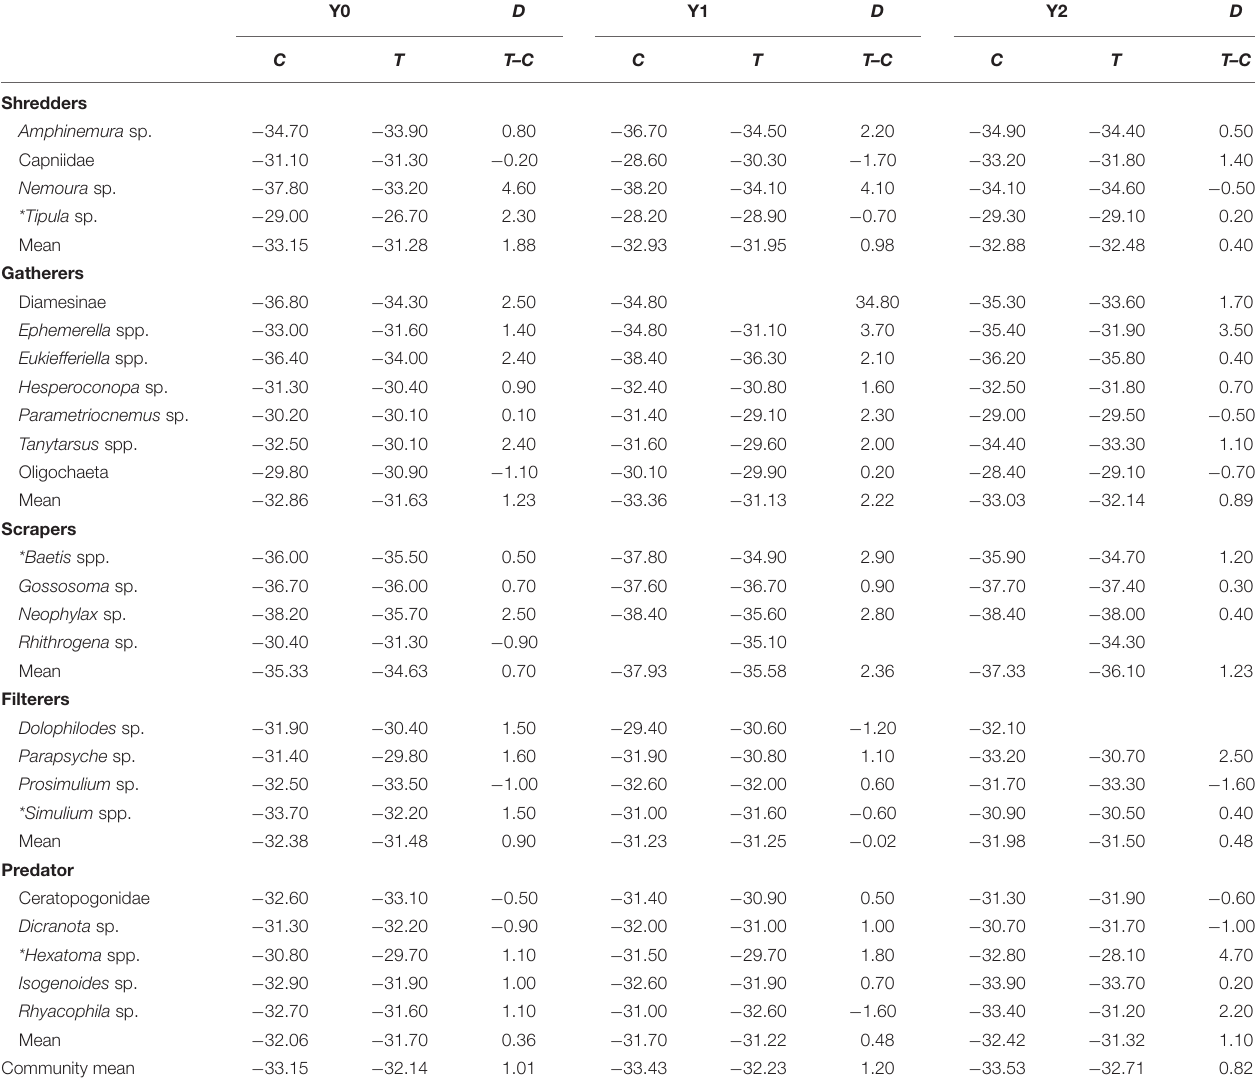
TABLE 1 | Mean annual δ 13 C values for each